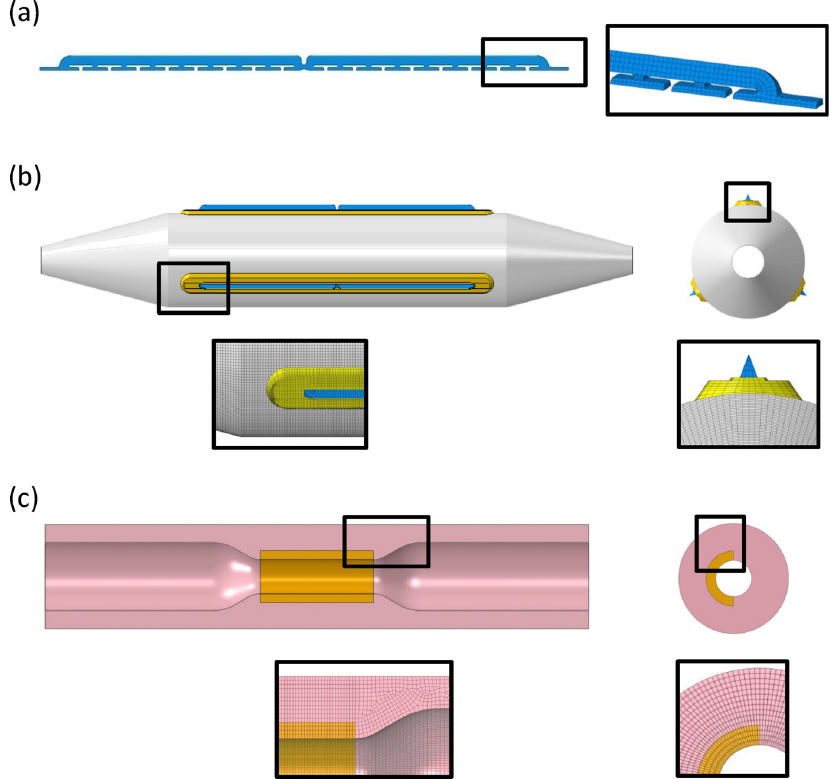
Fig 1. Geometries and mesh models for (a) blade, (b) balloon with pad and blade, and (c) coronary artery with calcified artery model .